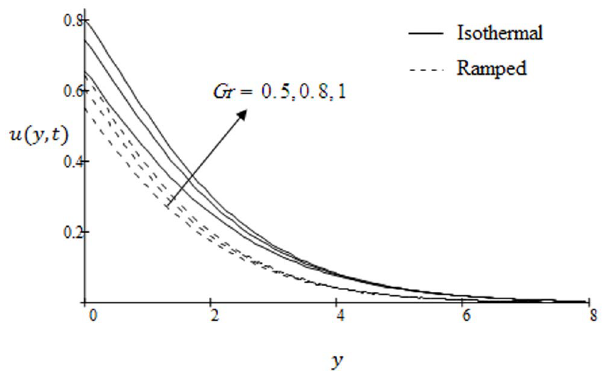
Figure 4. Velocity profiles for different values of Sc when the plate applies a constant shear stress f ~{ 0 : 25